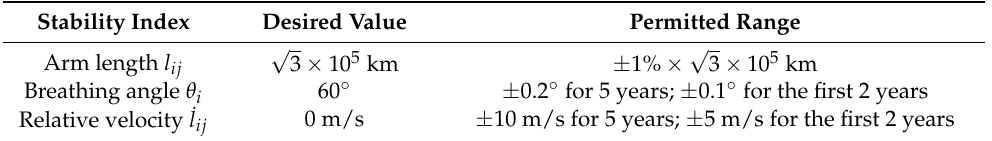
Table 2. The desired value and permitted range of the stability